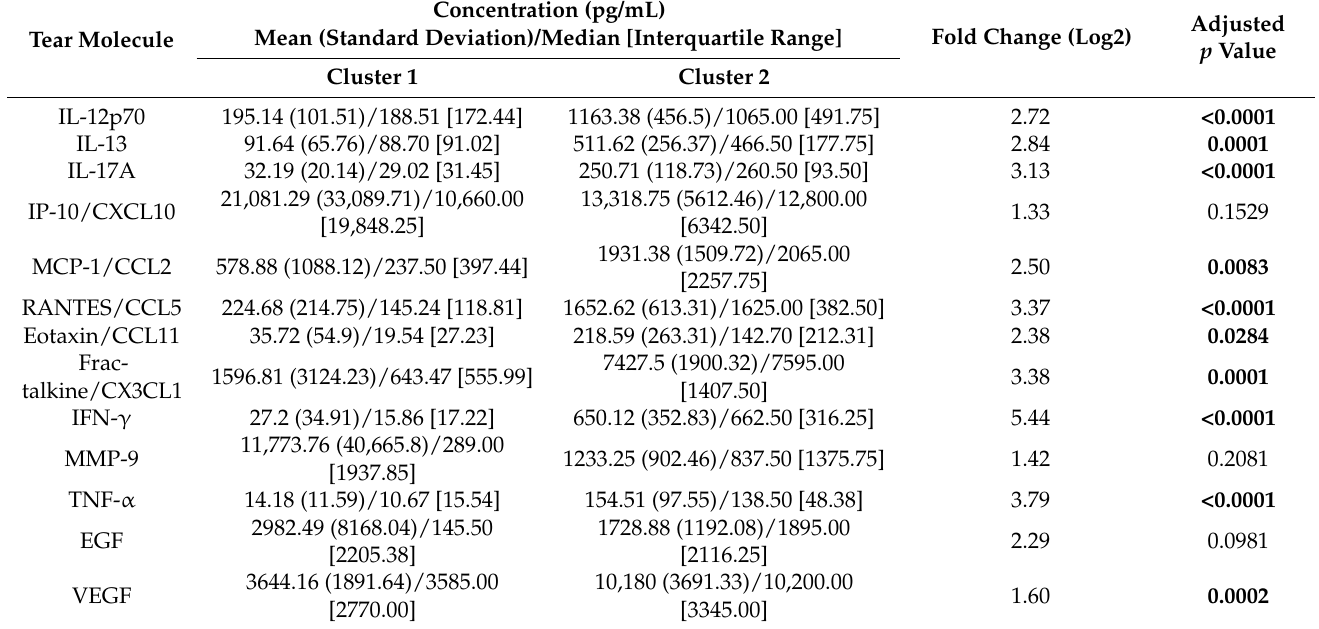
Table 7. Results of Clinical Tests, Esthesiometry, and Corneal Imaging in Patients Classified as Cluster 1 and Cluster 2 Based on Tear Cytokine Levels.